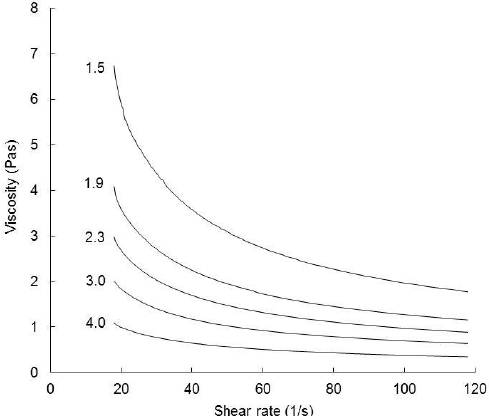
Figure 6. Flow curves of unsalted fermented milk–wheat composites (FMWC), reconstituted to 16.7% total solids, at 60 °C. The fermented milk-to-wheat ratio of the FMWC was 1.5, 1.9, 2.3, 3.0, or 4.0, as shown.